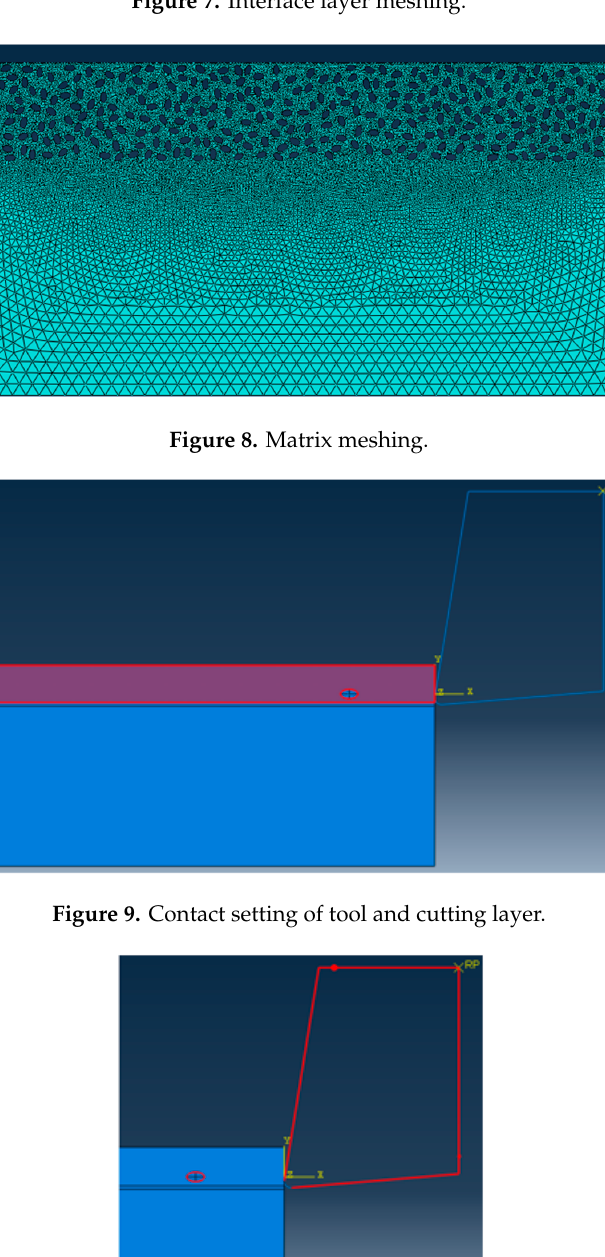
Figure 7. Interface layer meshing.